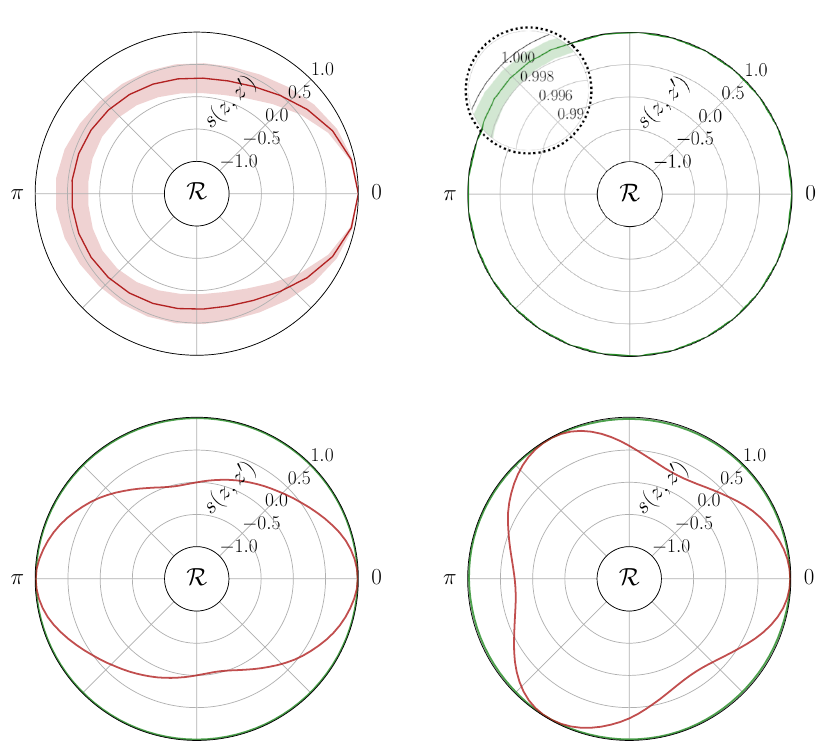
Figure 5: Visualization of the rotational invariance in representation space, keeping in mind that s ( z , z (cid:48) ) = 1 indicates identical representations. Top: JetCLR represen- tation trained without (left) and with (right) rotational transformations. Bottom: JetCLR representation for two-prong (left) and three-prong (right) toy jets, trained without (red) and with (green) rotational